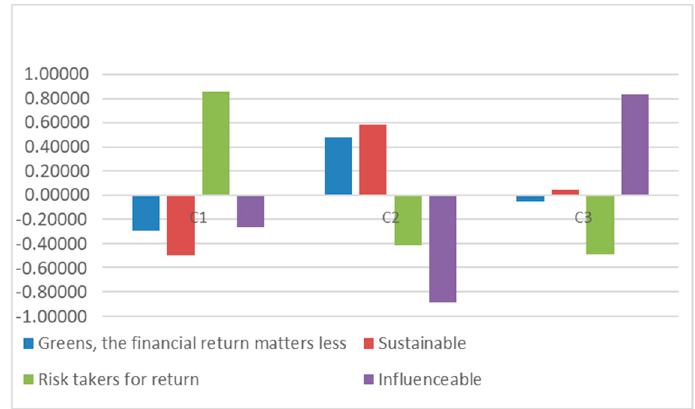
Figure 2. Clusters centroid. Table 4. Characterization of clusters based on sociodemographic characteristics.